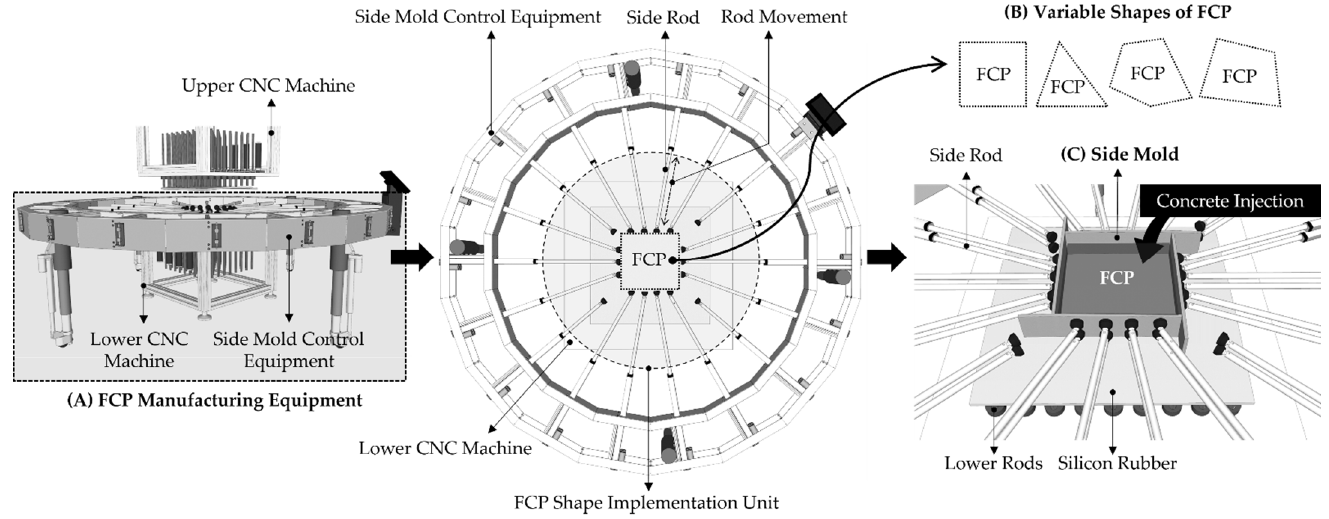
Figure 1. FCP Manufacturing Technology ( A : FCP Manufacturing Equipment, B : Variable Shapes of FCP, C : Side Mold)[8,9].